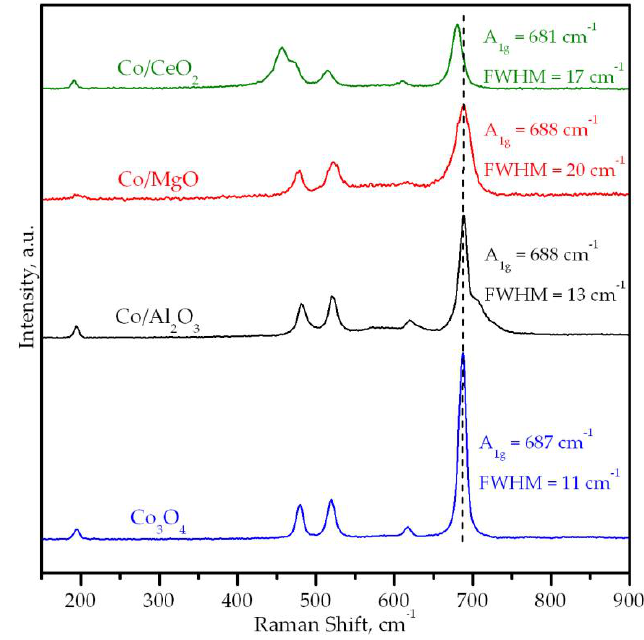
Figure 3. Raman spectra of the supported cobalt catalysts.